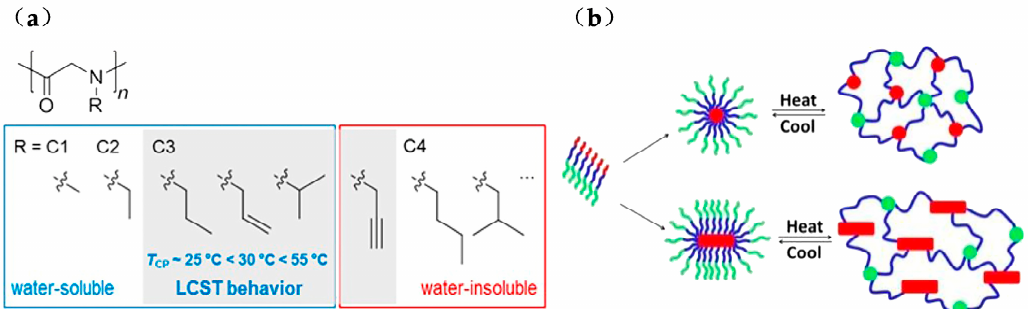
Figure 6. ( a ) T cp range of poly (N-C3 glycine)s (C3= n-propyl, allyl, propargyl and isopropyl). Reprinted with permission from [68]. Copyright 2013, American Chemical Society. ( b ) schematic showing the proposed gelation mechanism of aqueous solutions of the triblock copolypeptoids. Reprinted with permission from [29]. Copyright 2016, American Chemical Society.